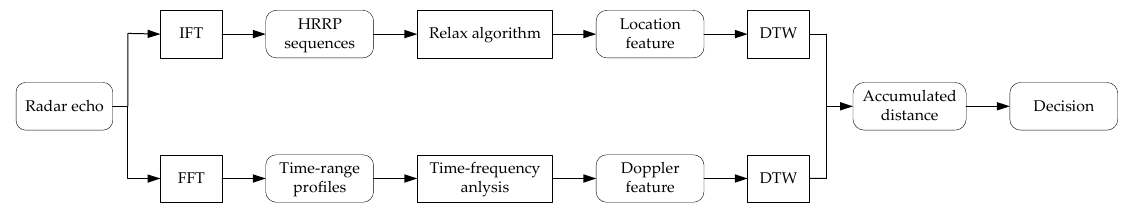
Figure 6. Overview of the recognition system.